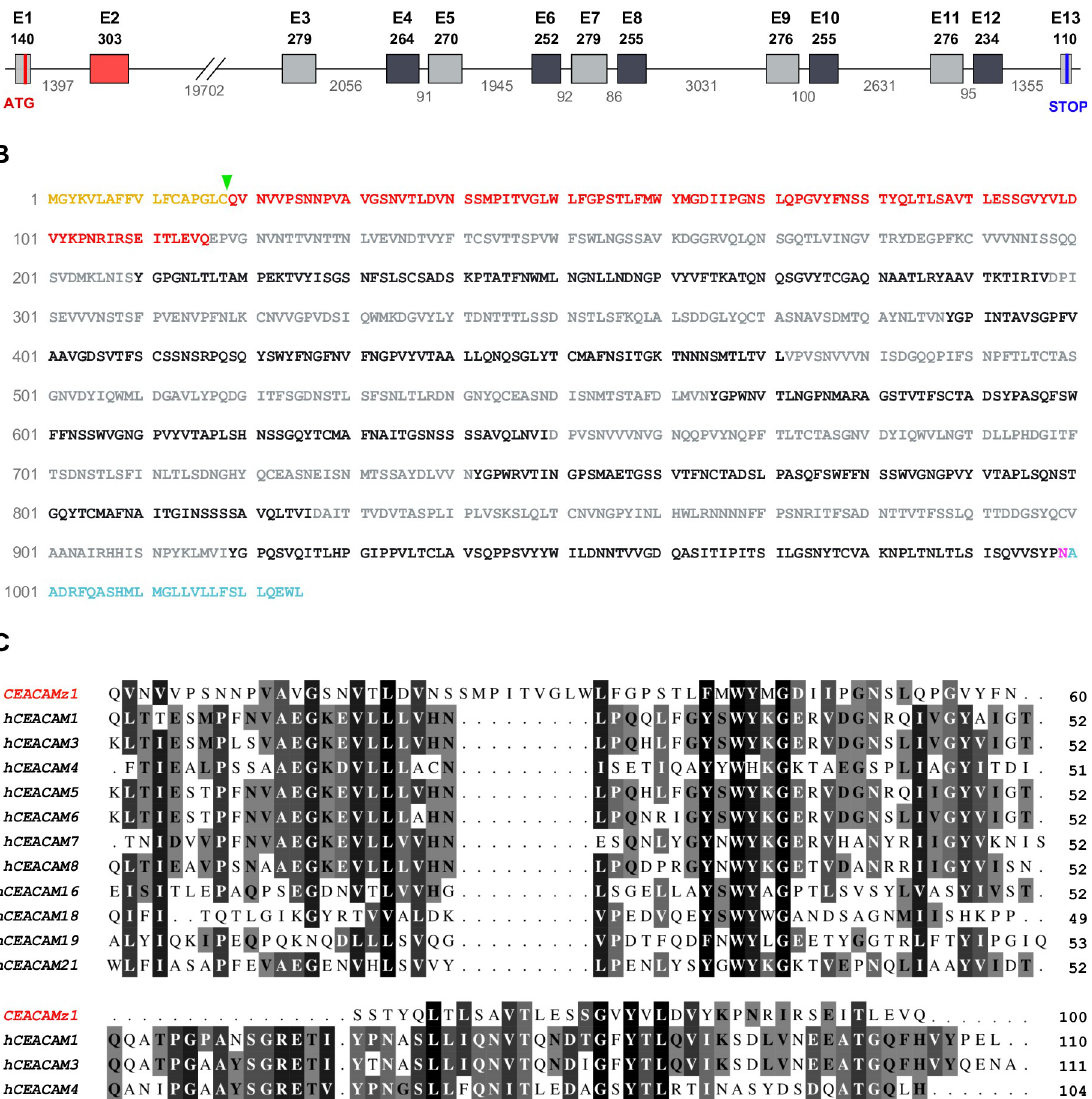
Fig 2. Sequence analysis of the ceacamz1 gene and its product. A. Organization of ceacamz1 coding region. The 35 kb-long ceacamz1 transcription unit is composed of 13 exons (red and grey boxes). The length in base pairs of the different exons and introns is indicated on the scheme. Each single Ig domain is encoded by a single exon (color-coded as in Fig 1). B. Protein sequence of CEACAMz1. The putative signal peptide is highlighted in orange and the green arrowhead indicates the most probable cleavage site (after Cys18). The Ig-V N- terminal domain is indicated in red. The Ig-C2 domains are highlighted in light grey (A-type) or dark grey (B-type). The ω -site for GPI- anchoring (Asn999) is displayed in purple. The residues highlighted in blue are cleaved off in the mature protein. C. Sequence alignment of the N-terminal Ig-V domain of CEACAMz1 with that of the twelve human CEACAMs. Amino acids are shaded from black to light grey according to their degree of conservation.